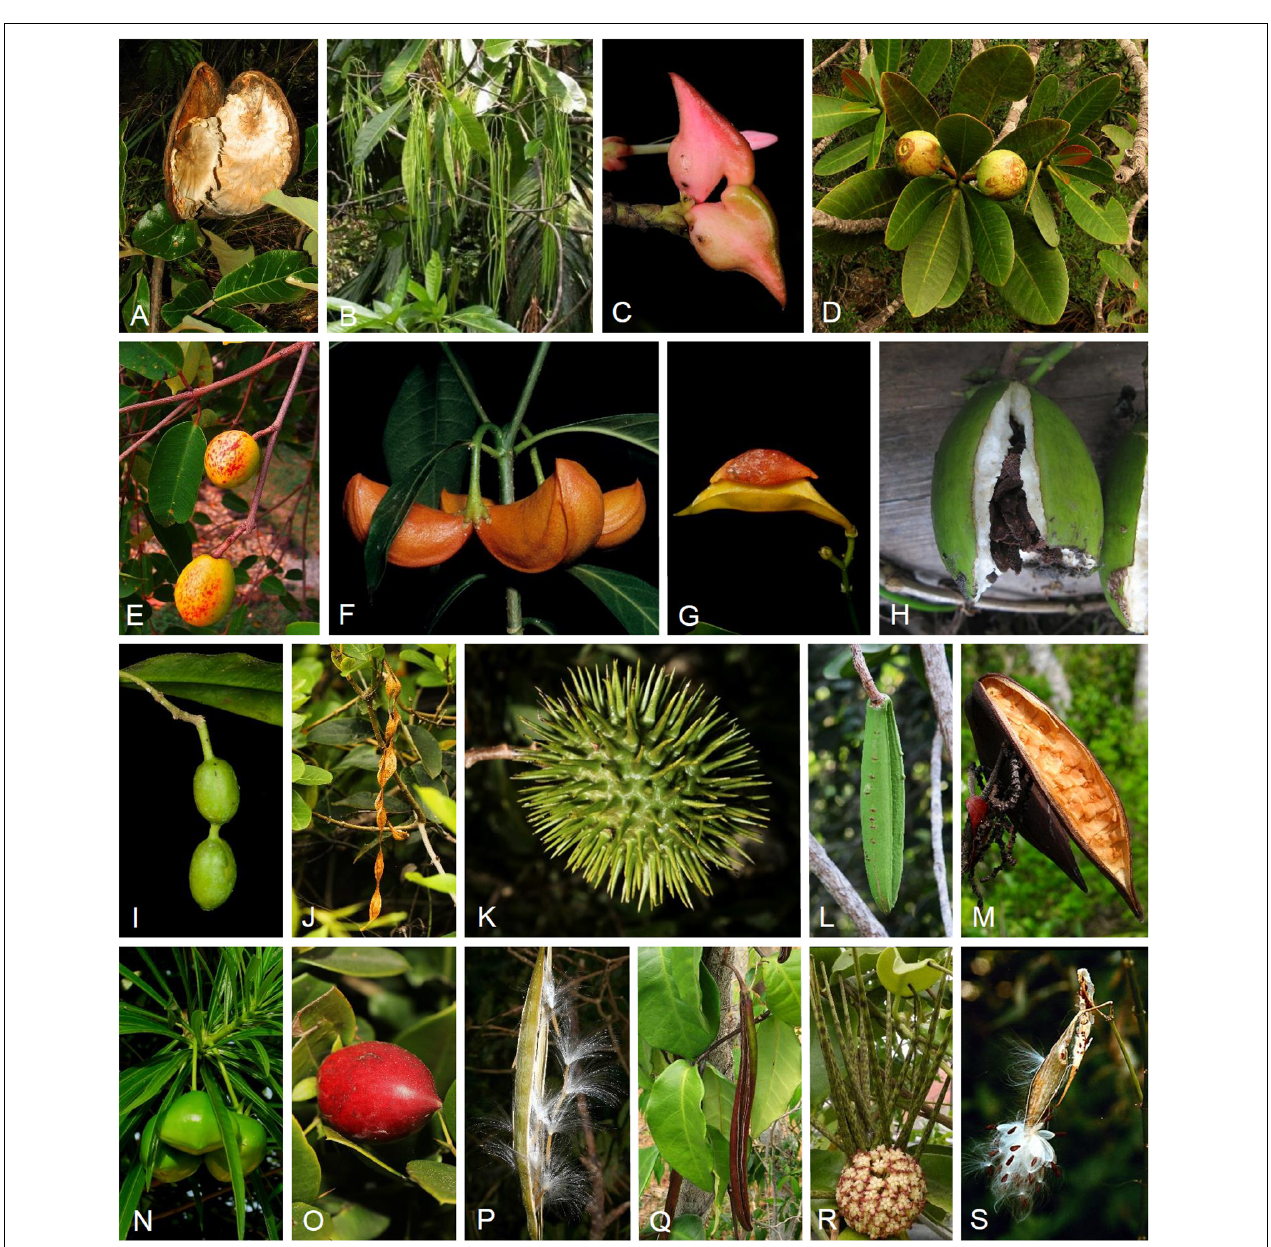
FIGURE 2 | Diversity of fruits and seeds in Apocynaceae. (A) Open follicle with winged seeds of Aspidosperma macrocarpon , Aspidospermateae; (B) Follicles of Alstonia macrophylla , Alstonieae; (C) One-seeded drupes of Kopsia pauciflora , Vinceae; (D) Berries of Couma rigida , Willughbeieae; (E) Berries of Hancornia speciosa , Willughbeieae; (F) Follicles of Tabaernaemontana pauciflora , Tabernaemontaneae; (G) Dehisced follicle with arillate seed of T. bovina , Tabernaemontaneae; (H) Berry with seeds of Spongiosperma grandiflorum , Tabernaemontaneae; (I) Torulose drupe with two articles of Alyxia siamensis , Alyxieae; (J) Torulose drupes with several articles of Condylocarpon isthmicum , Alyxieae; (K) Spiny capsule of Allamanda cathartica , Plumerieae; (L) Pair of fused immature follicles of Himatanthus drasticus , Plumerieae; (M) Open follicle with winged seeds of H. bracteatus , Plumerieae; (N) Drupaceous fruits of Thevetia peruviana , Plumerieae; (O) Berry of Carissa macrocarpa , Carisseae; (P) Open follicle with comose seeds of Wrightia pubescen s subsp. lanitii, Wrightieae; (Q) Fused follicles of Temnadenia violacea, Echiteae; (R) Inflorescence with flowers and follicles of Hoya incrassata , Marsdenieae; (S) Comose seeds from an old fruit of Asclepias curassavica, Asclepiadinae [Photos of panels (A,D,E,J–O,Q,S) by Rapini; panels (B,G) by Middleton; panels (C,I) by Preecha Karaket, with permission from The Forest Herbarium Bangkok; panels (F,R) by Meve; panel (H) by Simões; panel (P) by Leonid Averyanov].